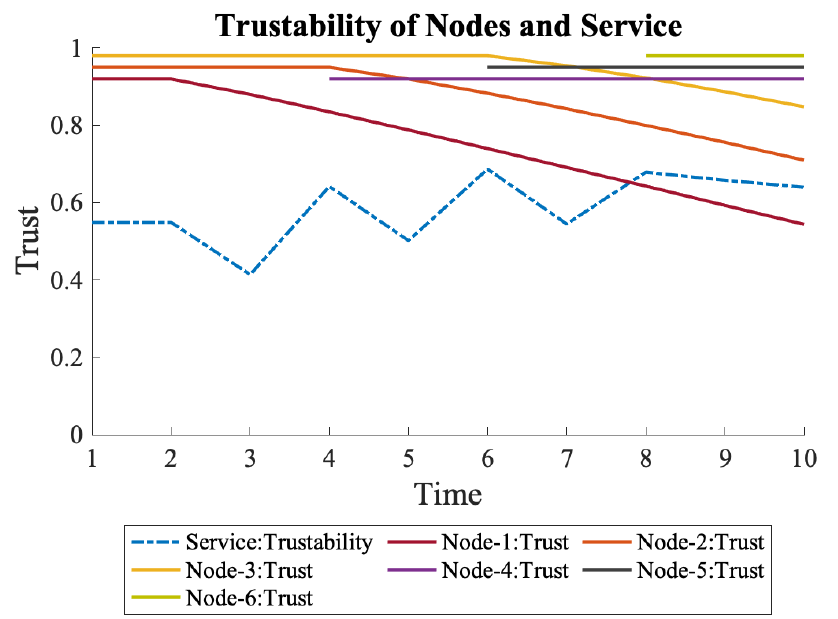
Figure 15. The entire trustability of the system increases each time a new node is launched and connected in parallel to the initial nodes.